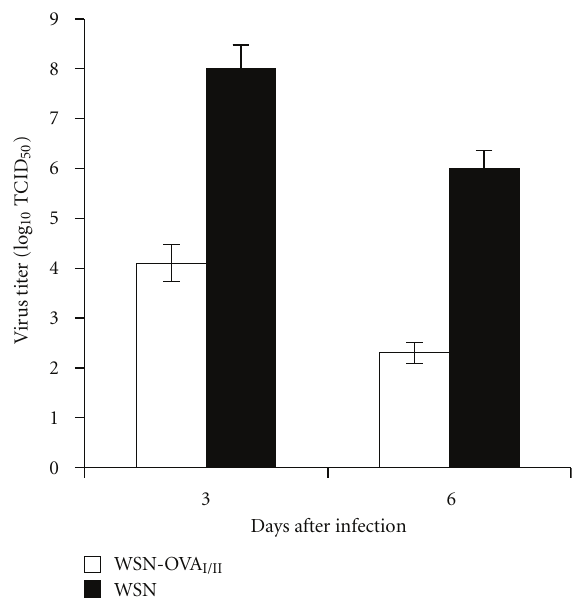
Figure 3: Replication of WSN-OVA I / II virus in mice. C57BL/6J mice were inoculated i.n. under anaesthesia with 5 × 10 2 PFU of WSN virus or 3 × 10 5 PFU of WSN-OVA I / II virus, and sacrificed on days 3 and 6 after infection for virus titration in lungs on MDCK cells. The values presented are averages of triplicate wells; the error bars indicate the standard